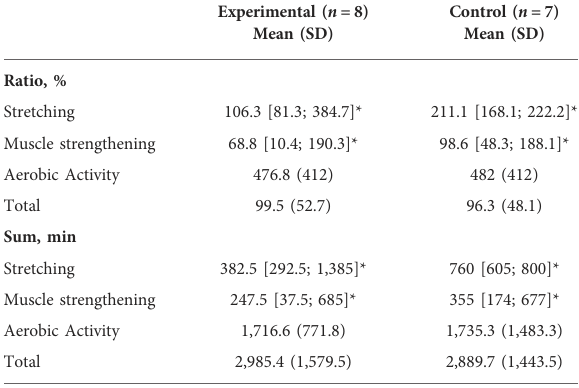
TABLE 1 Exercise compliance over the 12-week home-based